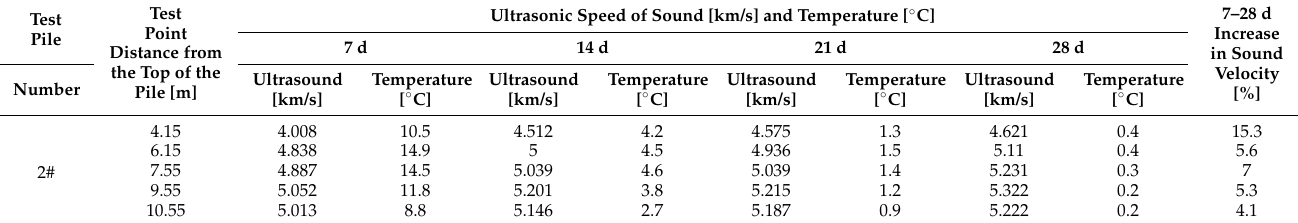
Table 6. 2# test pile frozen 7–28 d ultrasonic sound velocity and temperature record